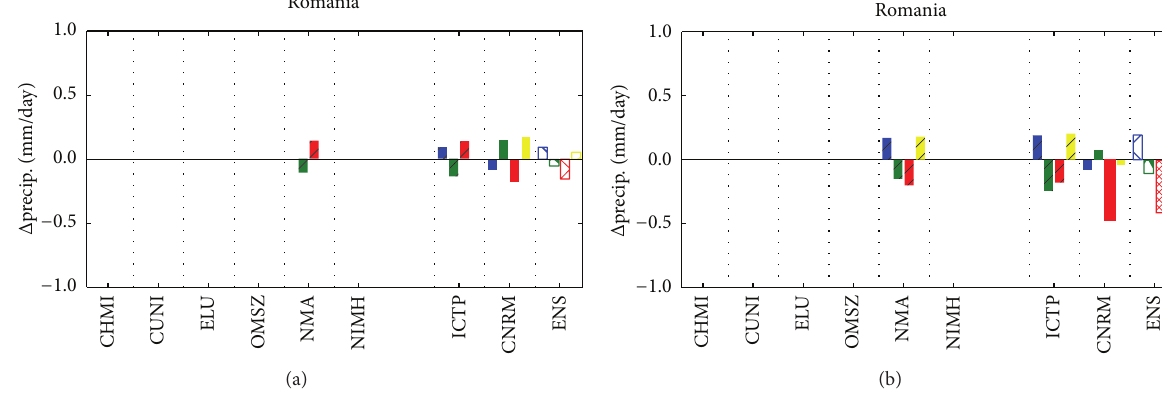
Figure 13: As Figure 10 for